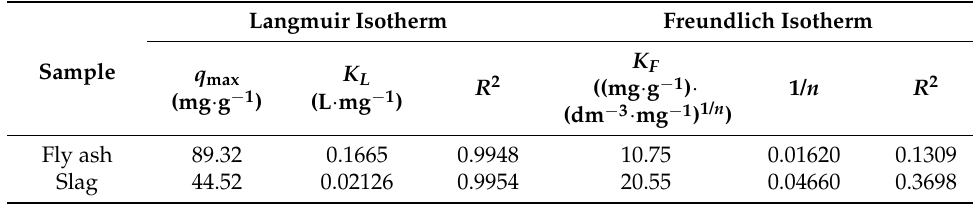
Table 4. Coefficient of Langmuir and Freundlich isotherms for